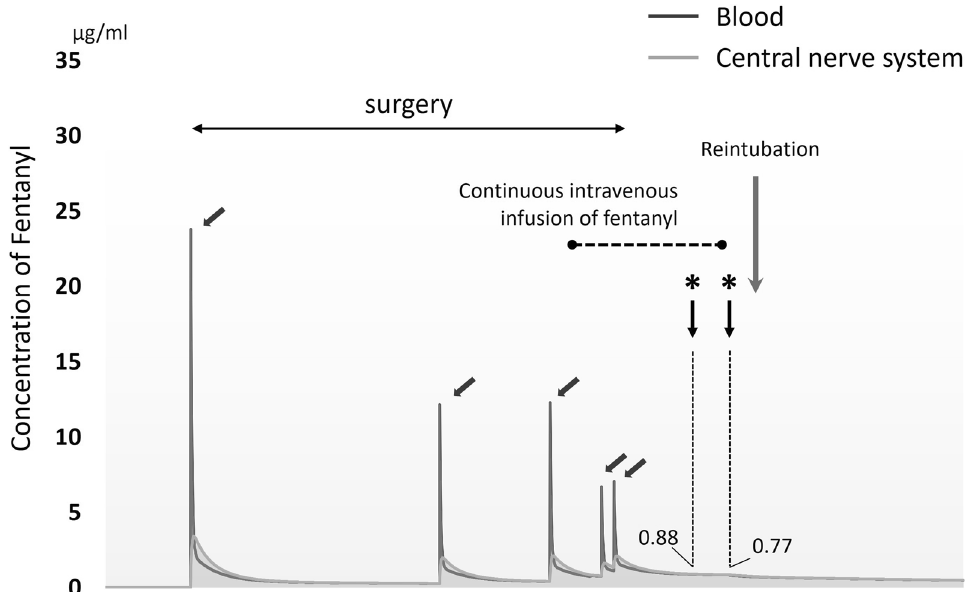
Fig. 3 Estimated concentration of fentanyl at the central nerve system (grey curve) and plasma (black curve) drawn by Tivatrainer software. The logo “*” shows the timing of TLOC. Diagonal arrow shows the shot of fentanyl. The fentanyl concentration of central nerve system at the TLOC was 0.88 and 0.77 ng/ml, respectively. TLOC transient loss of